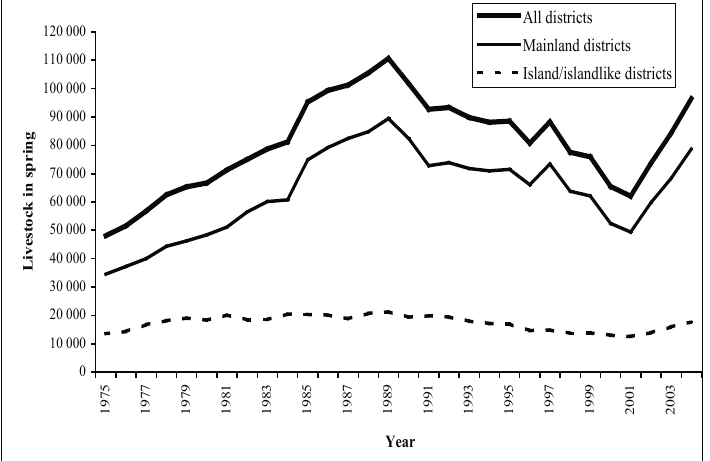
Fig. 2. The fluctuations in the reindeer spring population in West-Finn- mark (1975 - 2005) (continuous bold line) and for mainland (continuous line) and island (discontinuous line) districts separately (Reindriftsforvalt- ningen,